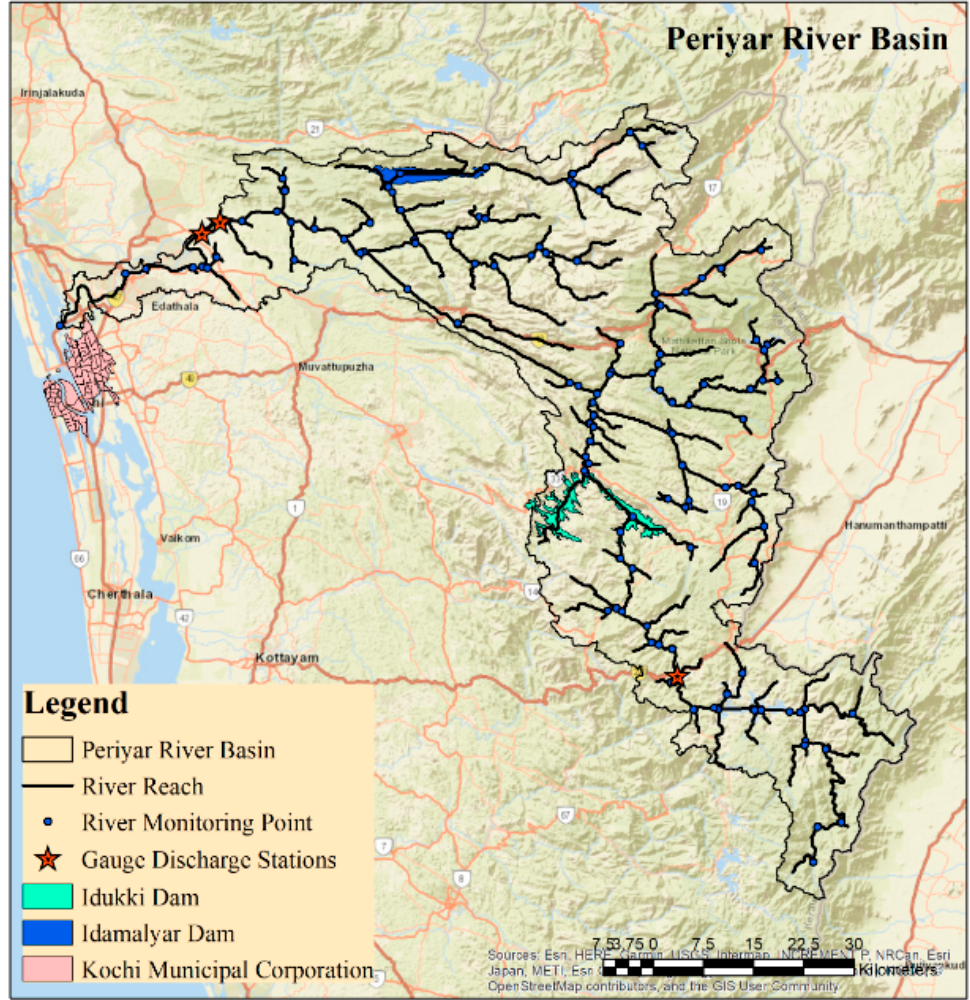
Figure 1. Study Area Showing Basin, Watershed, Reach, River Monitoring Point, and Gauge Discharge Station Locations.